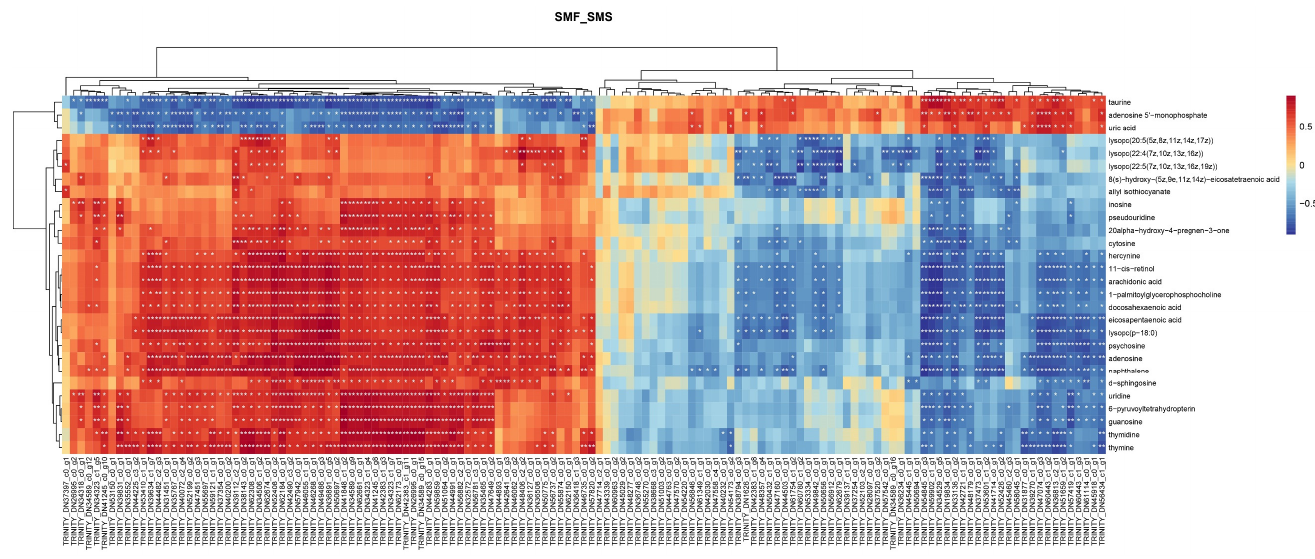
Figure 5. Heat map of the correlation between the transcriptome and metabolome of S. monotuberculatus . The columns are genes and the rows are metabolites; they show the relationship between genes and metabolites. Red indicates that genes and metabolites show positive correlation, blue indicates negative correlation between genes and metabolites. “*” indicates a significant correlation between genes and metabolites ( p < 0.05). “**” indicates p <